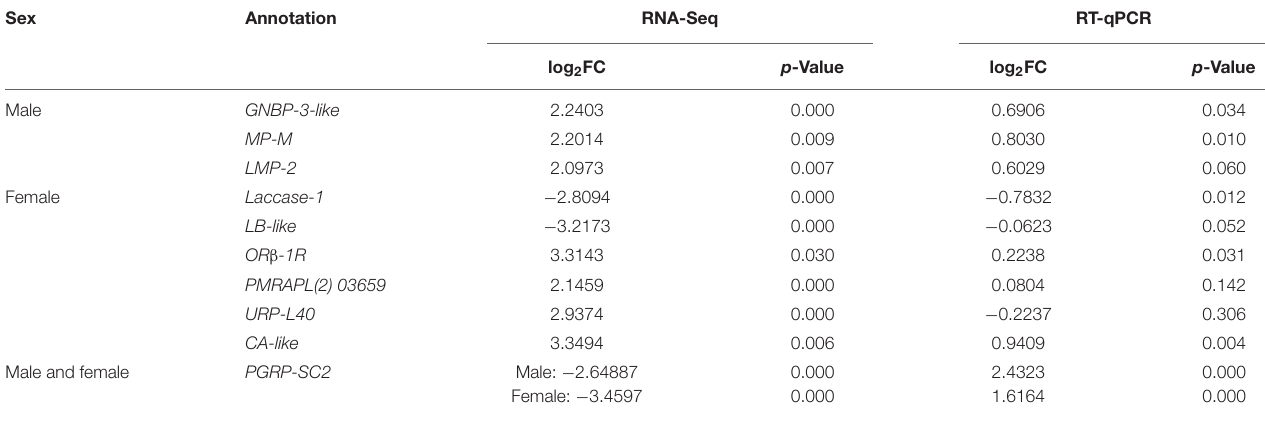
TABLE 3 | Expression of immune-related genes and their RT-qPCR